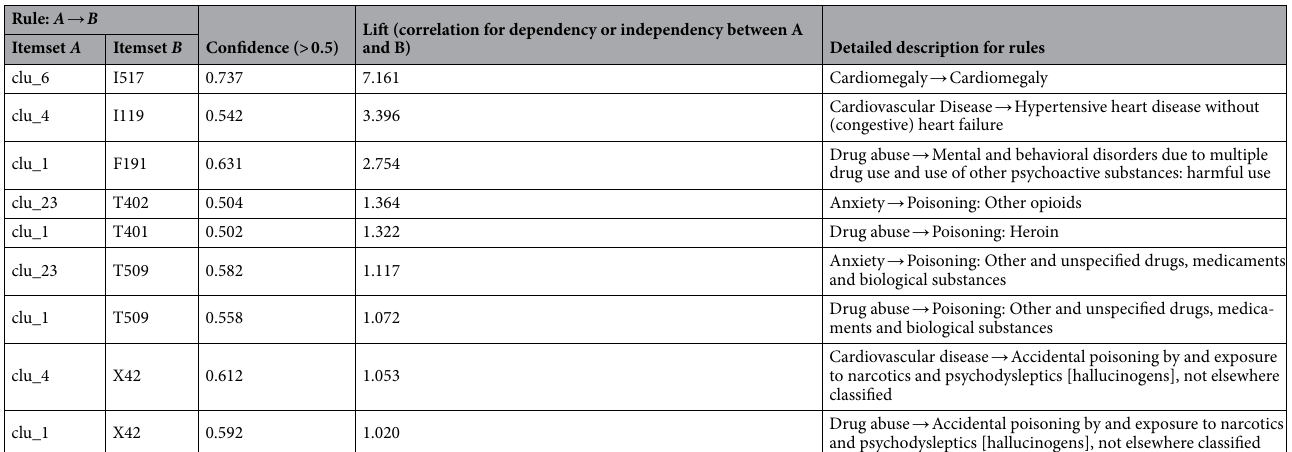
Table 2. List of the selected association rules which contain health condition in itemset A and cause of death in itemset B ordered by Lift value (≥ 1).